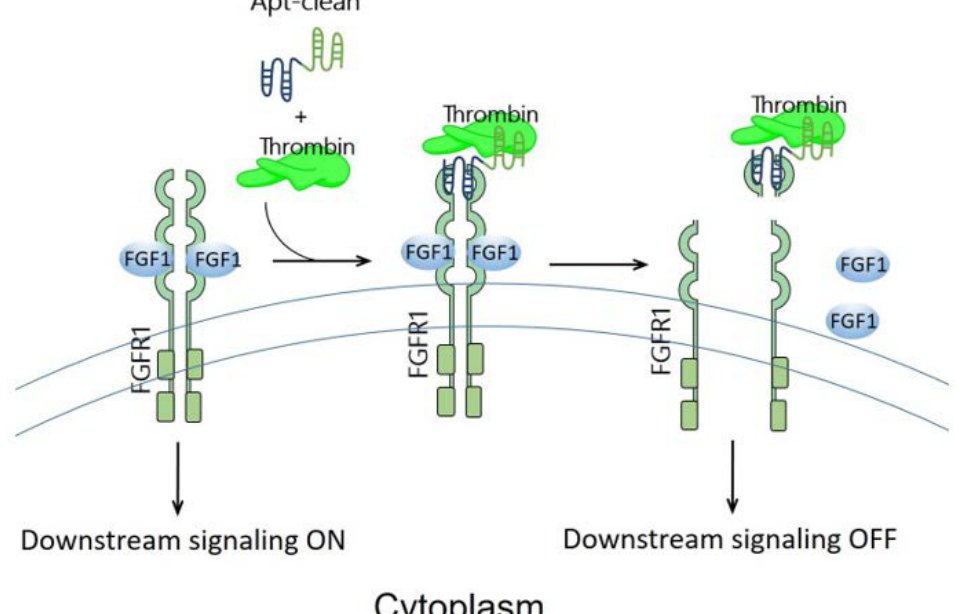
Figure 4. Schematic representation of the design of Apt-clean bispecific aptamer molecules. Essen- tially, Apt-clean bispecific aptamers consist of an aptamer for a POI (e.g., FGFR1) colored in blue, and another aptamer for a protease (e.g., thrombin) colored in green; generally, a linking moiety is not needed in between the aptamers. The degradation pathway is not UPS-dependent; instead, it relies on the protease activity of thrombin to initiate catalytic proteolysis.